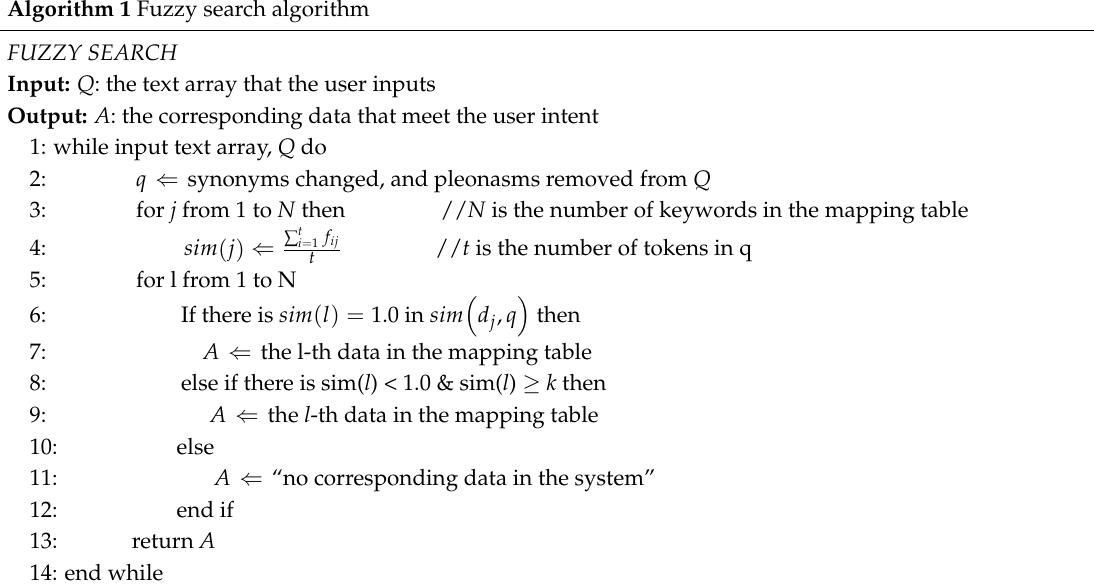
Algorithm 1 Fuzzy search algorithm FUZZY